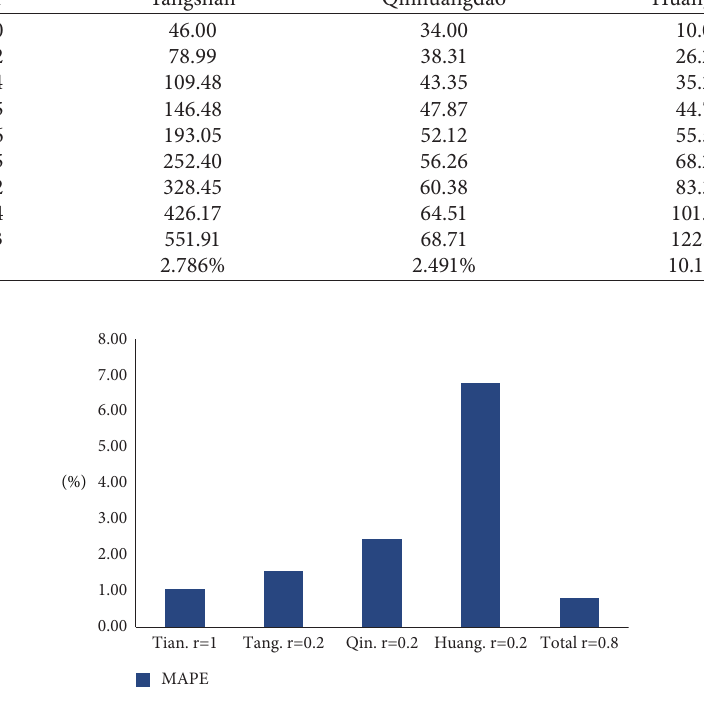
Figure 3: MAPE for the optimized orders of the FGM